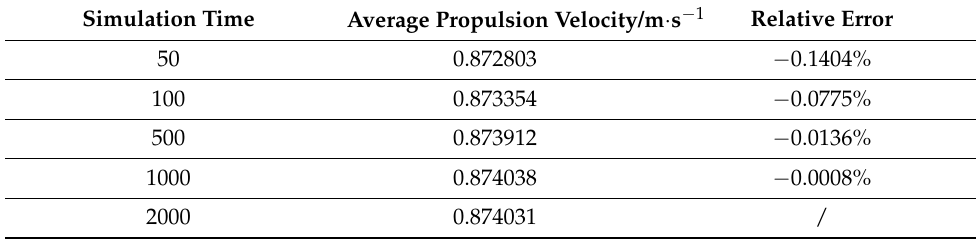
Table 3. Average propulsion velocity under different simulation